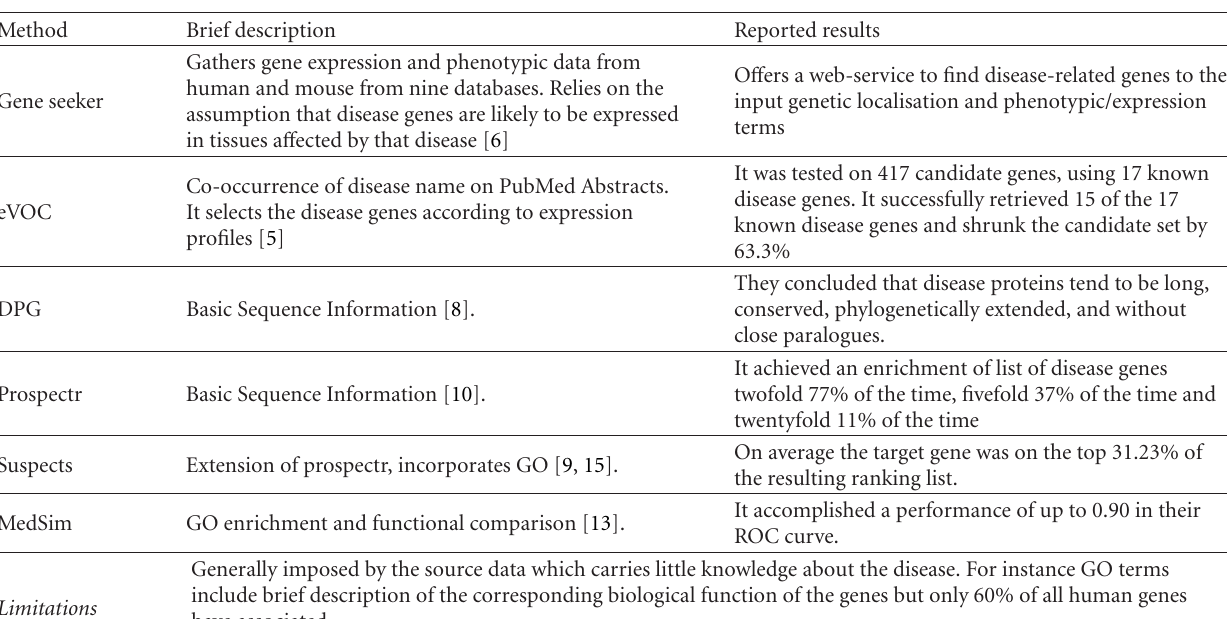
Table 6: Data and Text Mining Gene Prioritization Methods.